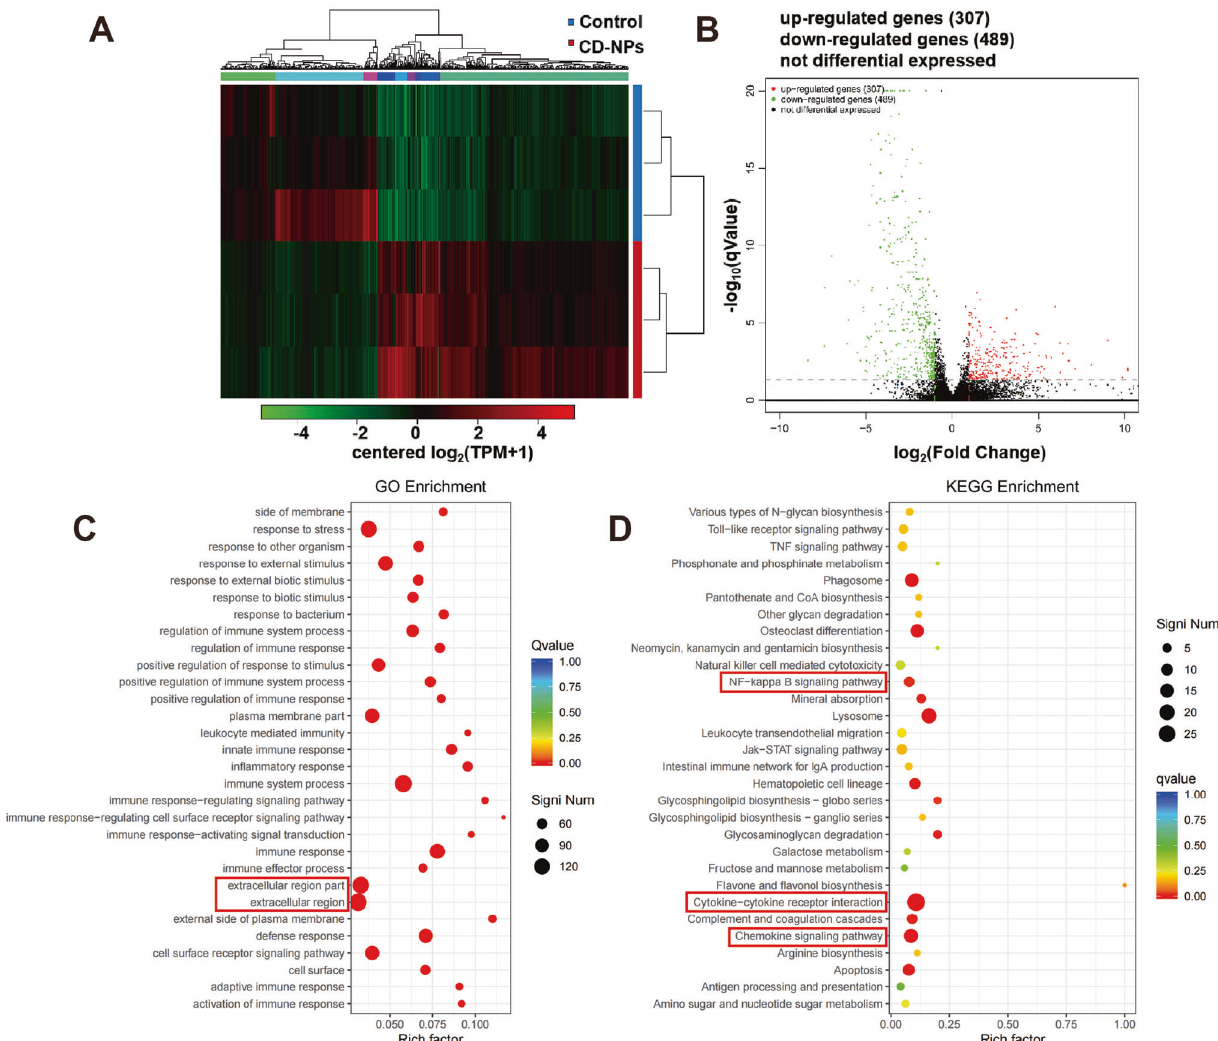
Fig. 5 High-throughput gene sequencing analysis of lung tissue based on in vivo pre- fi brosis model mice. A Clustering heatmap of differential gene expression in normal mouse lung tissue and pre- fi brotic model mouse lung tissue. In the fi gure, each row represents a gene, and each column represents a sample. The color represents the expression level of the gene in the sample. Red represents the gene with high expression level in the sample, and green represents the low expression level. B Volcano plot of differential gene expression in normal mouse lung tissue and pre- fi brotic model mouse lung tissue. The horizontal axis is the fold-change value of the gene expression difference between samples in different groups, and the vertical axis is the statistically signi fi cant p Value representing the change in gene expression. The smaller the pValue, the larger the difference in − log 10 (pValue), the more obvious the difference. Each dot represents a gene, where red indicates upregulated genes, green indicates down-regulated genes, and black indicates non-differential genes. C GO enrichment analysis of differentially expressed genes. The vertical axis represents the functional annotation information, the horizontal axis represents the Rich factor corresponding to the function (the number of differential genes annotated to the function divided by the number of genes annotated to the function), and the red box marks the two functions with the most signi fi cant enrichment of differential genes. D KEGG-enrichment analysis of differentially expressed genes. The vertical axis represents the KEGG pathway information, the horizontal axis represents the Rich factor corresponding to the KEGG pathway (the number of differential genes annotated to the KEGG pathway divided by the number of genes annotated to the KEGG pathway), and the red boxes mark the three signaling pathways that are signi fi cantly enriched for the differential genes focused on in this